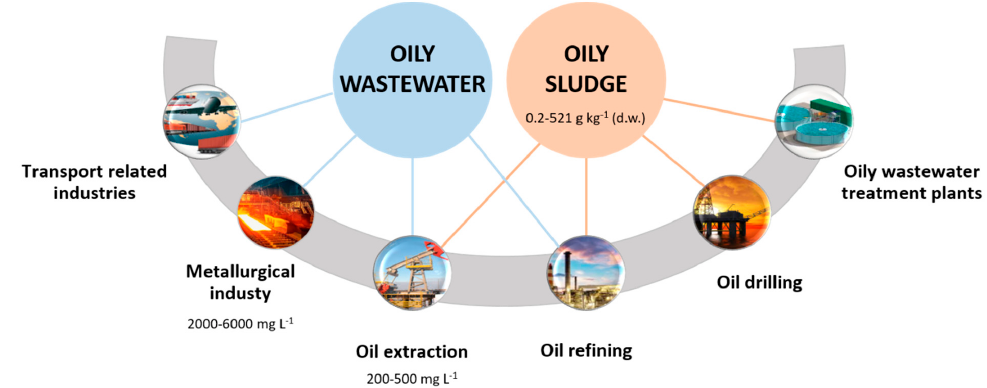
Figure 2. Different sources and average hydrocarbon concentrations found in oily wastewater and oily sludge. Table 1. Typical ranges of saturated and aromatic hydrocarbons in produced water (PW).